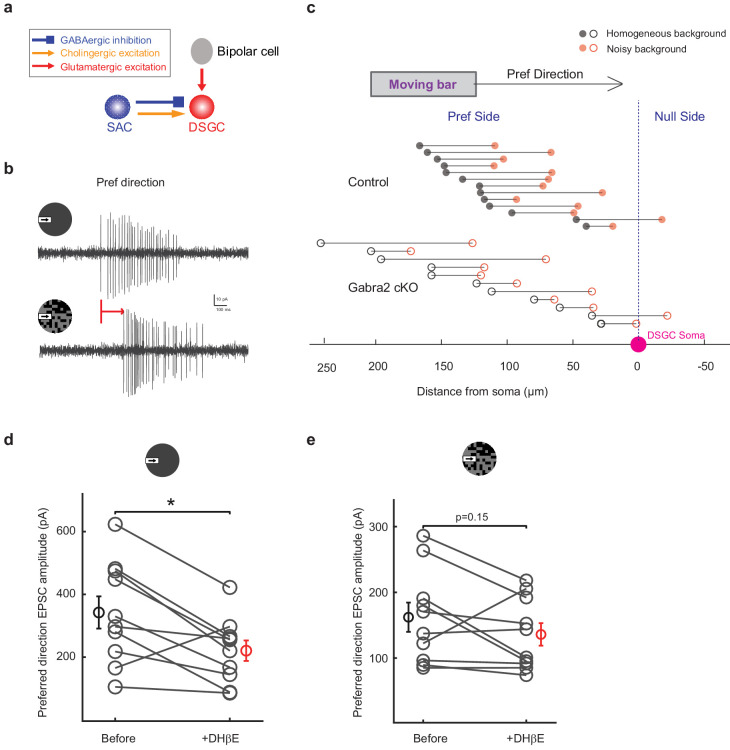
Excitatory inputs onto DSGCs in noisy background are primarily glutamatergic.(a) Schematic showing sources of synaptic inputs to DSGCs. Excitatory inputs to DSGCs include glutamatergic inputs from bipolar cells and cholinergic inputs from SACs. Cholinergic excitation of DSGCs from laterally connected SACs during the moving bar stimulus arrives earlier than glutamatergic excitation from vertically connected bipolar cells. (b) Example loose-attach recording of a control DSGC evoked by the leading edge of a moving bar in noise-free (upper) and noisy (lower) backgrounds. Red arrow indicates the delay of spiking onset in noisy background. (c) Spatial locations of the leading edge of the moving bar relative to the soma (pink dot at zero on the X-axis) at the onset of bar-evoked DSGC spiking response. For each DSGC, the bar locations for noise-free (black) and noisy (red) backgrounds are plotted at the same Y axis position and connected with a solid black line. Control group cells are represented by filled circles and Gabra2 cKO cells are represented by empty circles. The onset time of DSGC spiking activity was determined by a binless algorithm adapted from Chase and Young, 2007. Mean distance from soma: control noise-free background:127.6 ± 11.5 μm, control noisy background 73.0 ± 12.8 μm, n = 13 cells, Gabra2 cKO noise-free background: background 126.8 ± 21.5 μm, Gabra2 cKO noisy background 74.0 ± 17.7 μm, n = 11 cells. (d) Pair-wise comparison of preferred-direction EPSC amplitude evoked by the moving bar in noise-free background before and after application of 0.08 μM cholinergic receptor antagonist DhβE in control mice. n = 10 cells from five mice. (e) Same as d, during the moving bar stimulus in the noisy background.Figure 1—figure supplement 2—source data 1.Excitatory inputs onto DSGCs in noisy background are primarily glutamatergic.